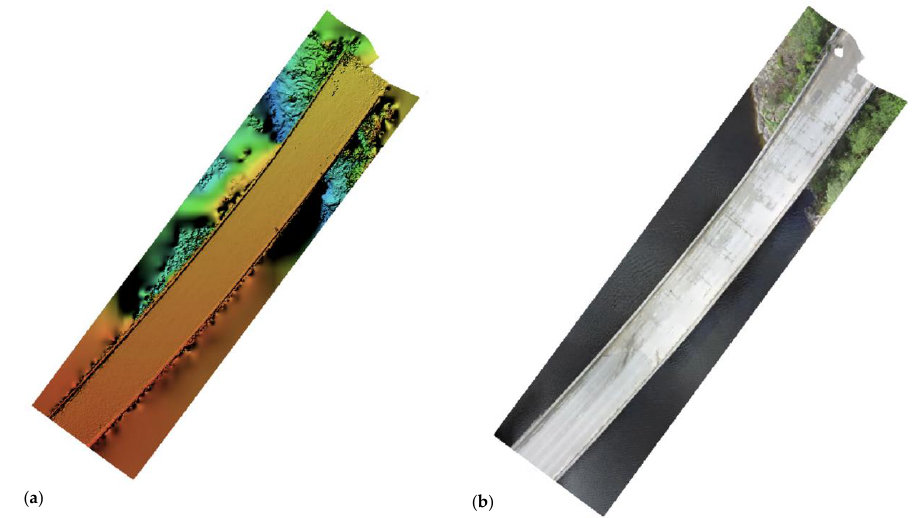
Figure 8. ( a ) Digital Surface Model (DSM) and ( b ) Orthomosiac output for Skodsberg Bridge.